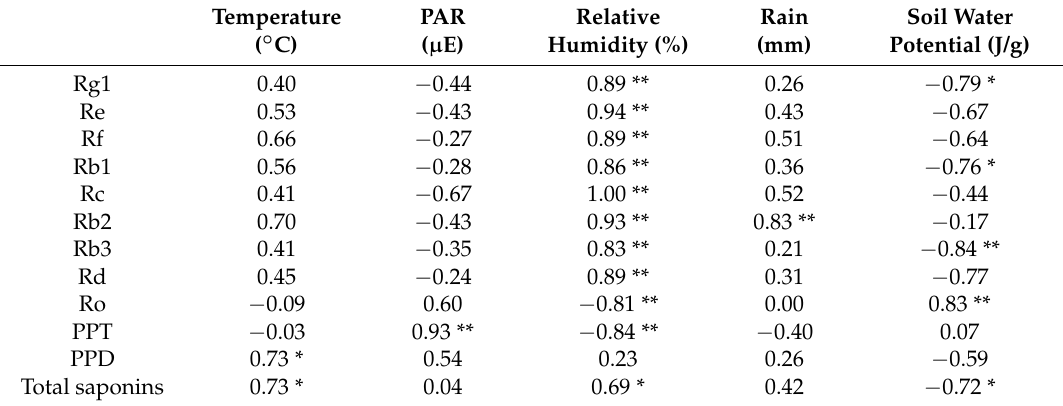
Table 8. Correlation analysis between environmental factors and ginsenosides in leaves at different growth times.